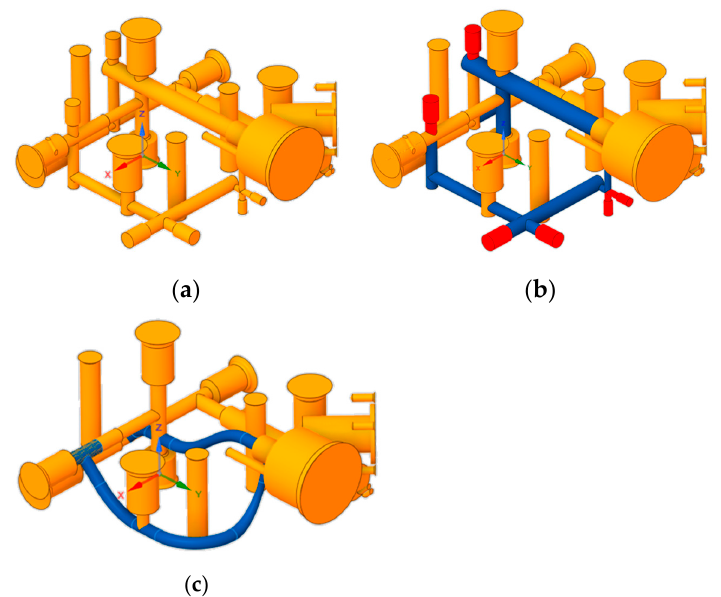
Figure 1. Automated CAD steps used for redesign of AM hydraulic manifold. ( a ) initial ducts of the conventional manifold (user input); ( b ) design optimization for AM: channel to be redesigned (blue); plugs to be removed (red); ( c ) final ducts of the AM manifold (user output).